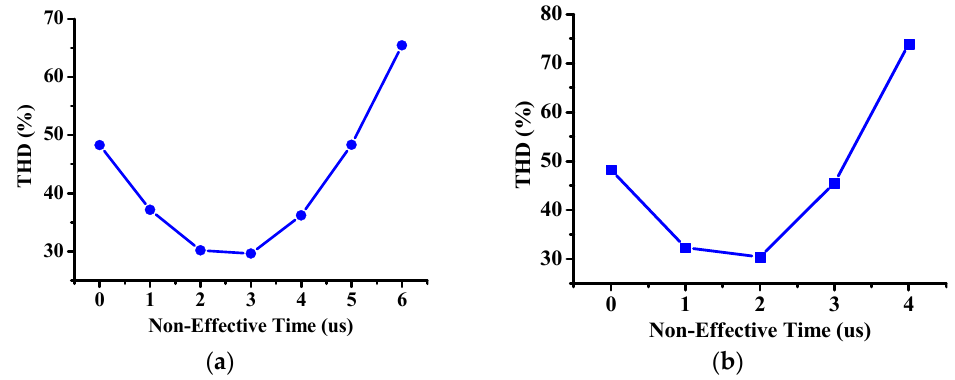
Figure 11. THDs of square waves with different non ‐ effective times at 50 kHz ( a ) and 80 kHz ( b ).